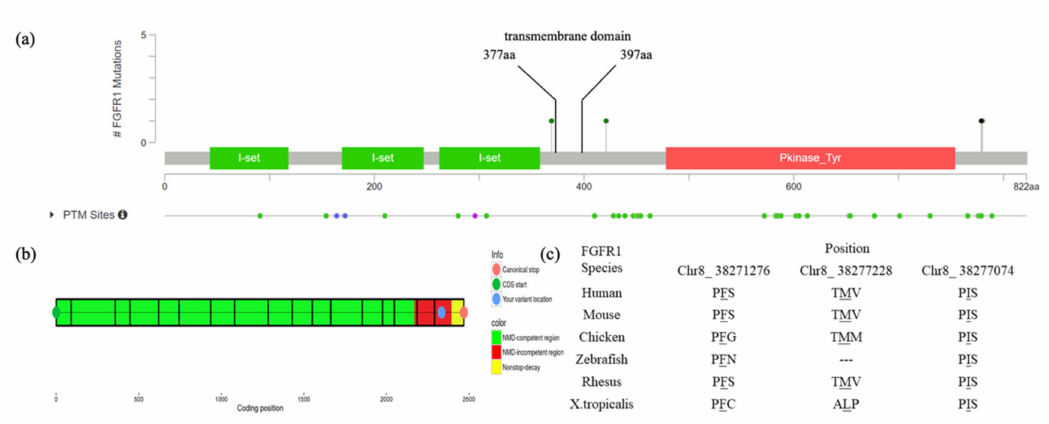
Figure 2. Mapping and conservation analysis of four variants: ( a ) Mapping of four FGFR1 variants revealed that c.2334dupC and c.2339T>C are located in the intracellular region and post-translational phosphorylation sites of the FGFR1 protein, whereas c.1261A>G is located in the transmembrane region and close to the post-translational phosphorylation site; ( b ) The result of NMD prediction of c.2334dupC showed that it is located in the NMD-incompetent region; ( c ) Mutation loci of the three missense variants (c.2339T>C, c.1261A>G and c.1107G>A) are highly conservative across different